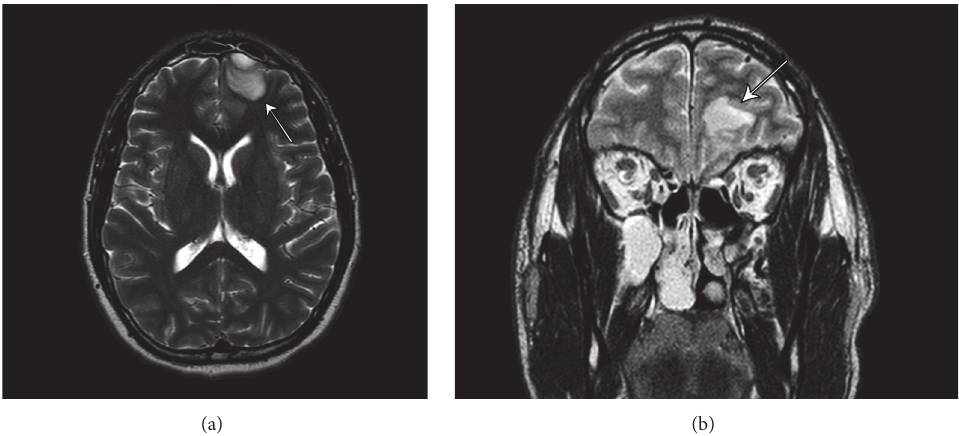
Figure 2: (a, b) show a 2.1cm epidural lesion in the left frontal region producing minimal mass effect on the left frontal lobe with adjacent edema of the left frontal lobe and multichamber sinusitis